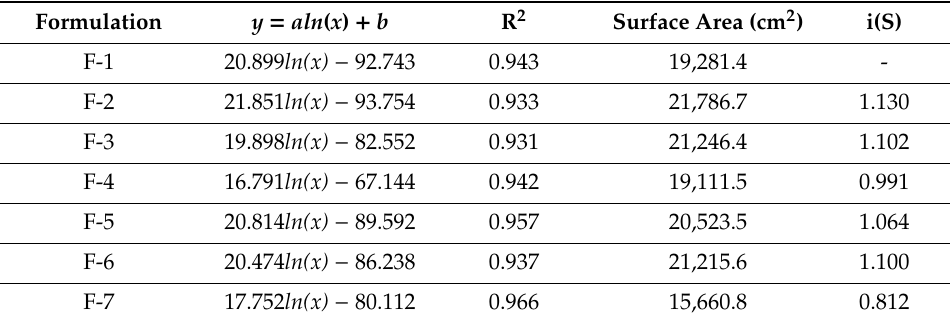
Table 2. Parameters describing the spreadability of the